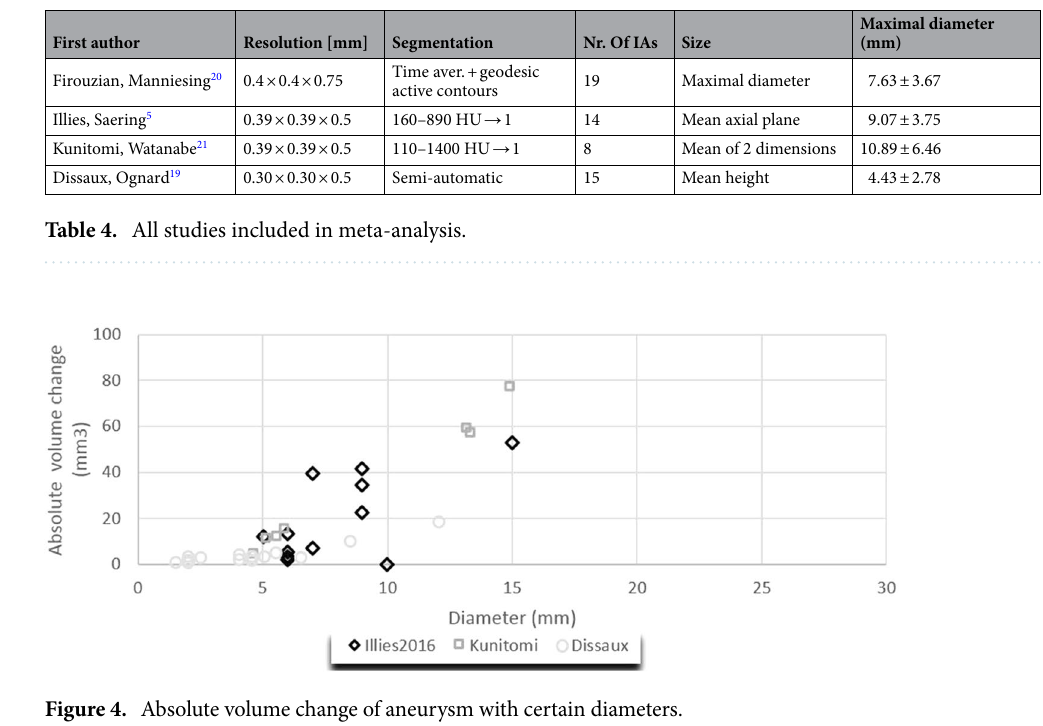
Figure 4. Absolute volume change of aneurysm with certain diameters.